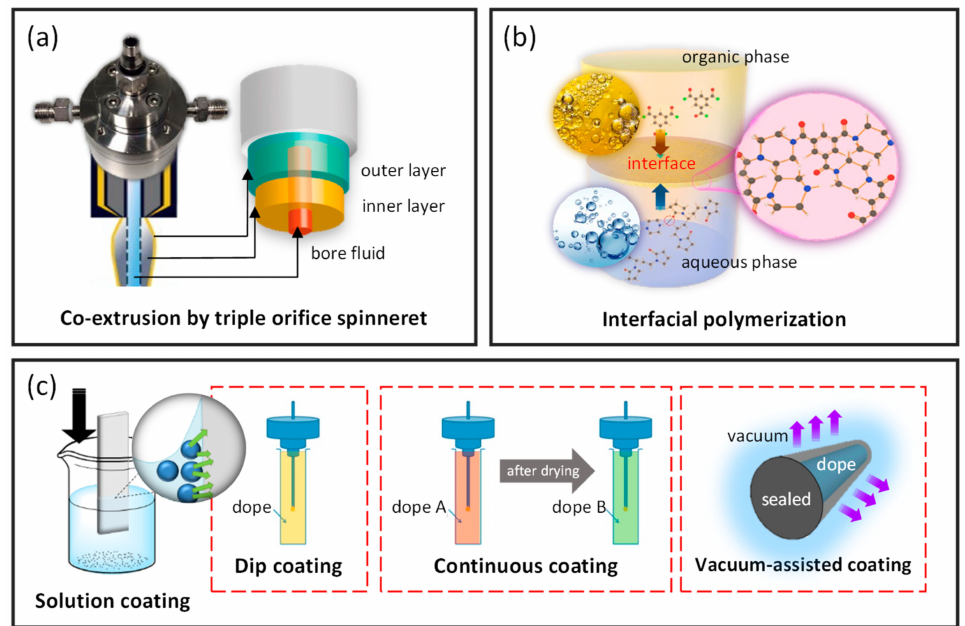
Figure 8. Various composite hollow fiber membranes fabrication techniques, including ( a ) co-extrusion, ( b ) interfacial polymerization, and ( c ) different solution coating